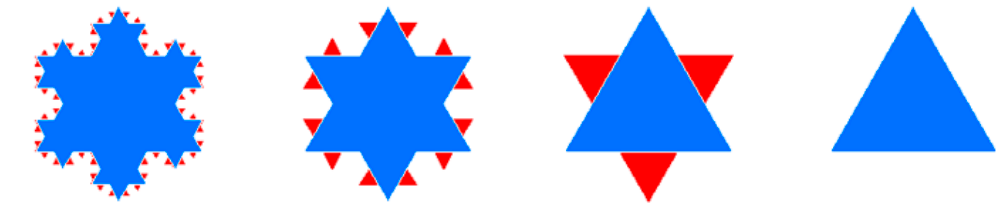
Figure 1. (Color online) The simplification process of the Koch snowflake guided by head/tail breaks. (Note: The blue polygons in each panel denote the head parts, whereas the red triangles represent the tail part, which needed to be eliminated progressively for generalization purpose).